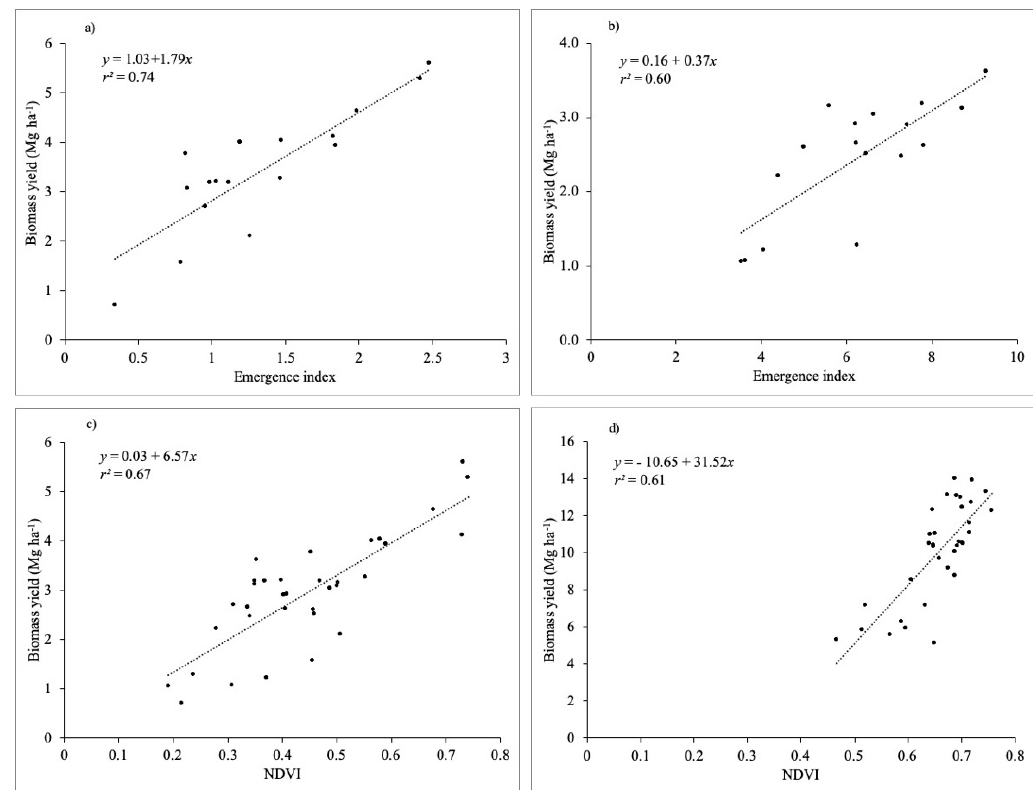
Figure 5. ( a ) Emergence index vs. biomass yield for early-seeding at first harvest, ( b ) emergence index vs. biomass yield for late-seeding at first harvest, ( c ) normalized difference vegetation index (NDVI) at 49 days after seeding (DAS) vs. biomass yield for first harvest, and ( d ) NDVI at 20 days after harvest (DAH) vs. biomass yield for second harvest in forage sorghum genotypes (G) averaged across four environments, Fargo and Hickson, ND, USA, in 2017 and 2018.